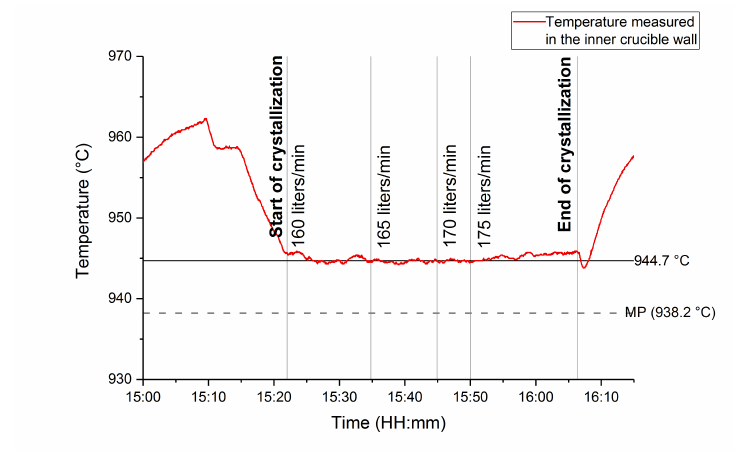
Figure 9. Influence of the gas cooling rate in the crystallization of germanium.